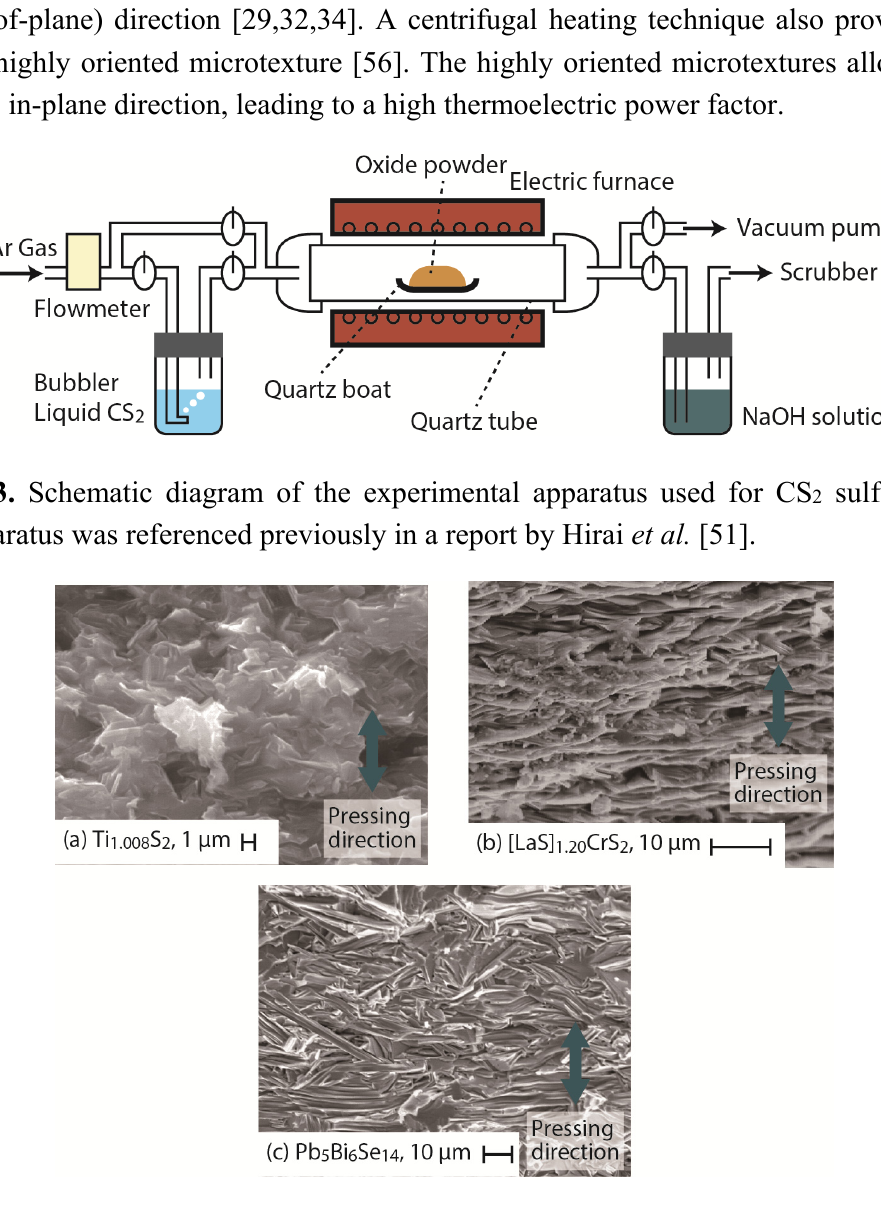
Figure 4. Scanning electron micrographs of the fractured section of sintered compacts of ( a ) Ti 1.008 S 2 [29]; ( b ) [LaS] 1.20 CrS 2 [32]; and ( c ) Pb 5 Bi 6 Se 14